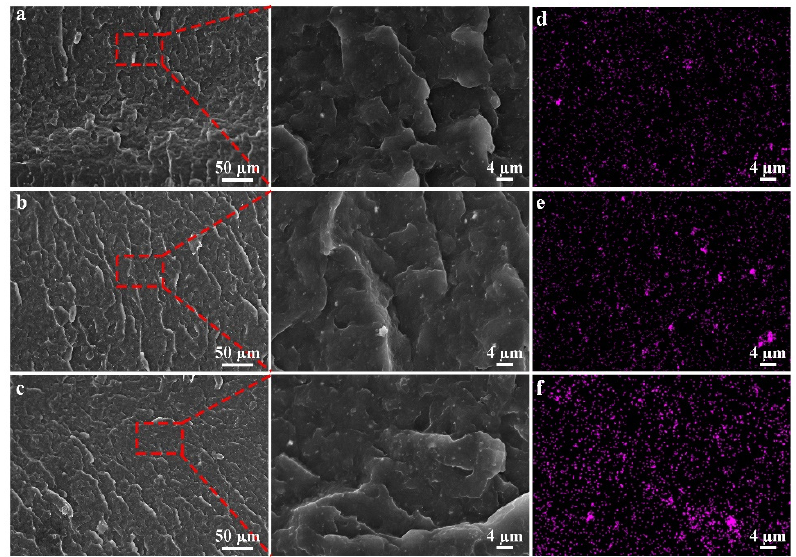
Figure 9. SEM images of ( a ) far-surface layer, ( b ) core layer, and ( c ) near-surface layer of specimen in cross section direction; EDS images of partial enlarged drawing of them ( d – f ), Purple dots repre- sent Ferrum.